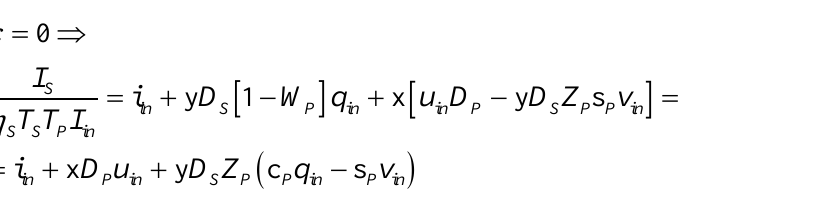
We get with a cleaned analyser and horizontally linearly polarised input I (125).